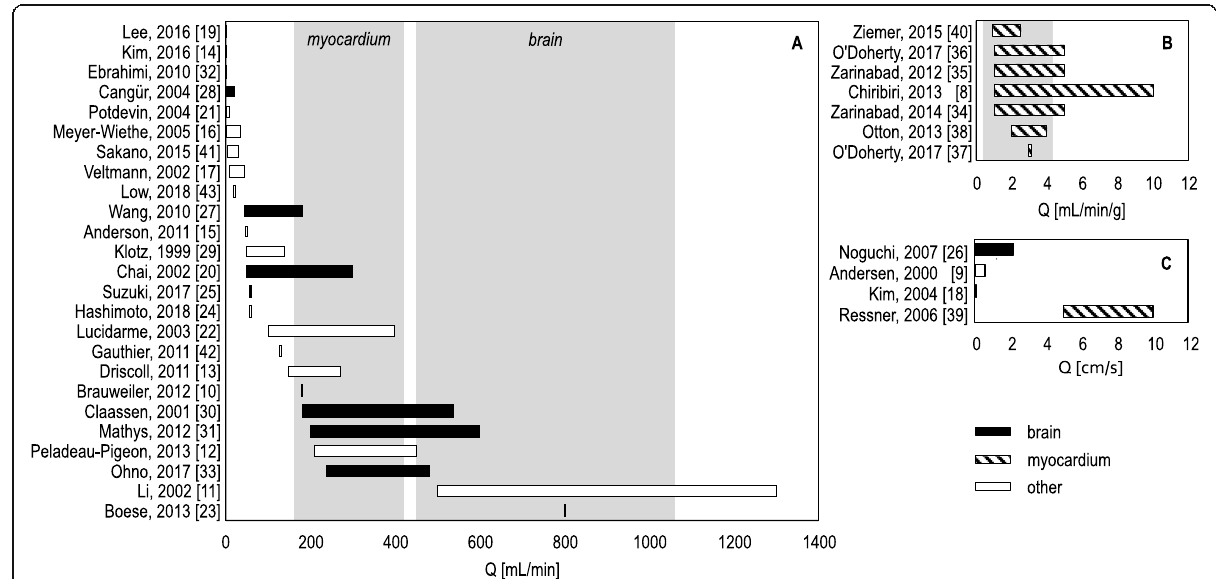
Fig. 4 Overview of used flow ranges and units in assessed perfusion phantom studies. ( a ) shows the studied flow ranges in mL/min, ( b ) in mL/ min/g, and ( c ) in cm/s. The grey blocks represent physiological flow ranges for brain and myocardial tissue [45,